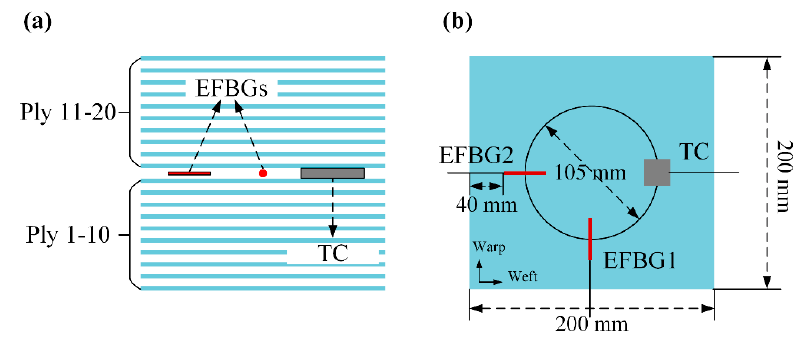
Figure 5. Sensors embedded in the composite: ( a ) front view and ( b ) top view.